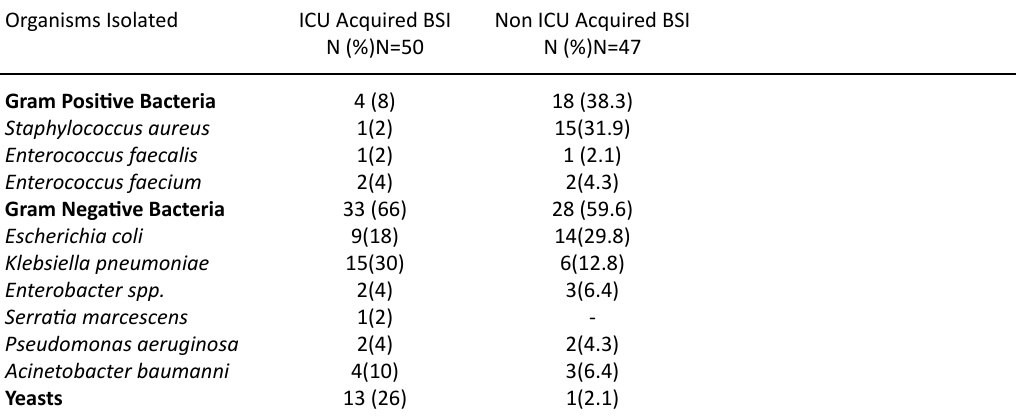
Table 3. Antimicrobial susceptibility pattern of Gram-negative pathogens isolated from BSI Antimicrobial drugs